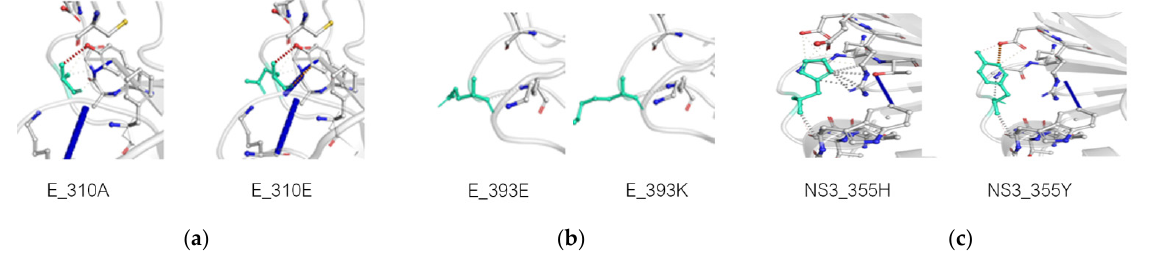
Figure 3. Effects of mutation on E and NS3 helicase protein stability and interactomics in the mutation region. Dynamut normal mode analysis (EnCoM) was used to analyze and visualize the potential impact of the mutations dynamics and stability resulting from vibrational entropy changes. PBD: 5LBV was used as the model of E protein. A310E ( a ) and E393K ( b ) are predicted to be stabilizing and decrease the flexibility of the protein. PBD: 5GJB was used as the model of NS3 helicase protein. The H355Y mutation is predicted to be a slightly destabilizing mutation and slightly increases the flexibility of the protein ( c ). Change in interactomics of the mutation residue (shown in green) with surrounding residues was also predicted for A310E ( a ), E393K ( b ), and H355Y ( c ).